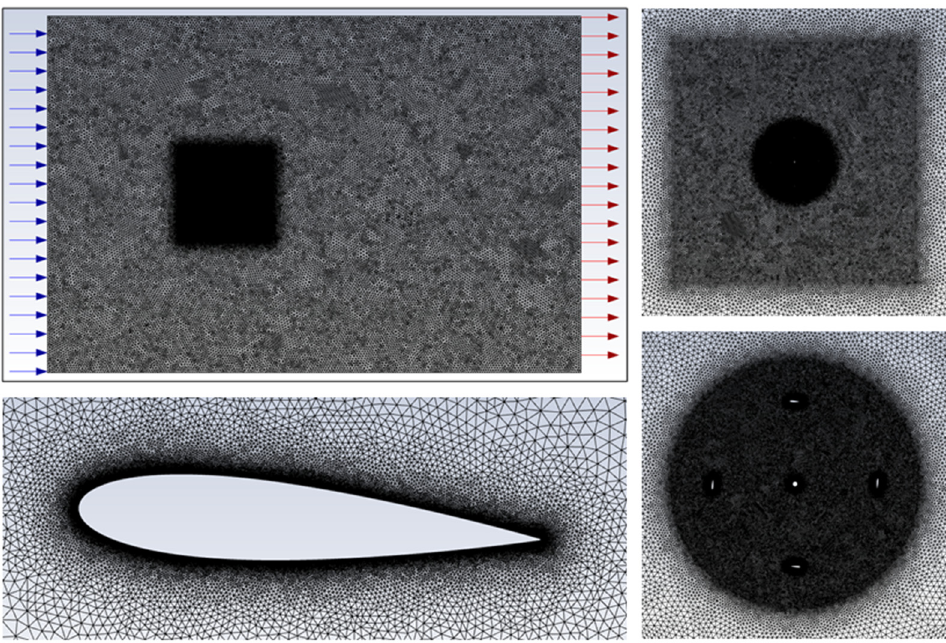
Figure 3. Flow domain meshing, with blue and red arrows indicating the inlet and outlet of the flow domain, respectively.